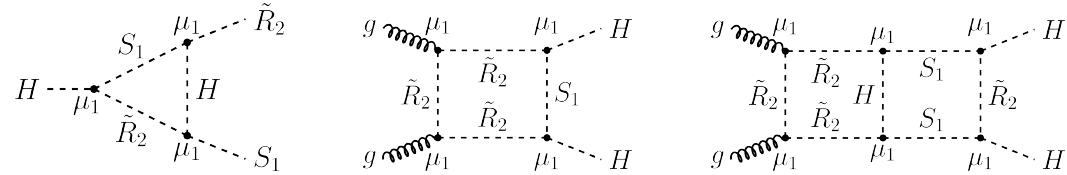
Figure 15. One Feynman diagram correcting the cubic coupling at one loop (left), and contribu- tions at one and two loops to gg → HH